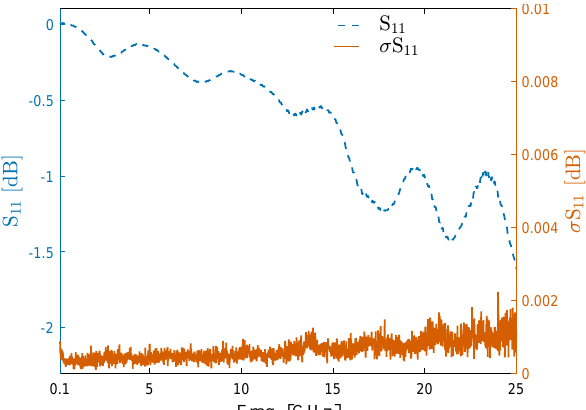
0.1 Freq. [GHz] Figure 3. Measured reflection coefficient (S 11 ) of the unloaded ICB and the standard deviation between several measurements in